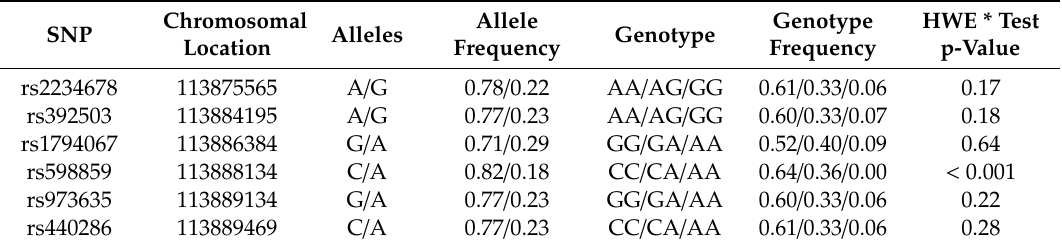
Table 2. Tag IL1RN SNPs allele and genotype frequencies in New York University Bellevue Asthma Registry